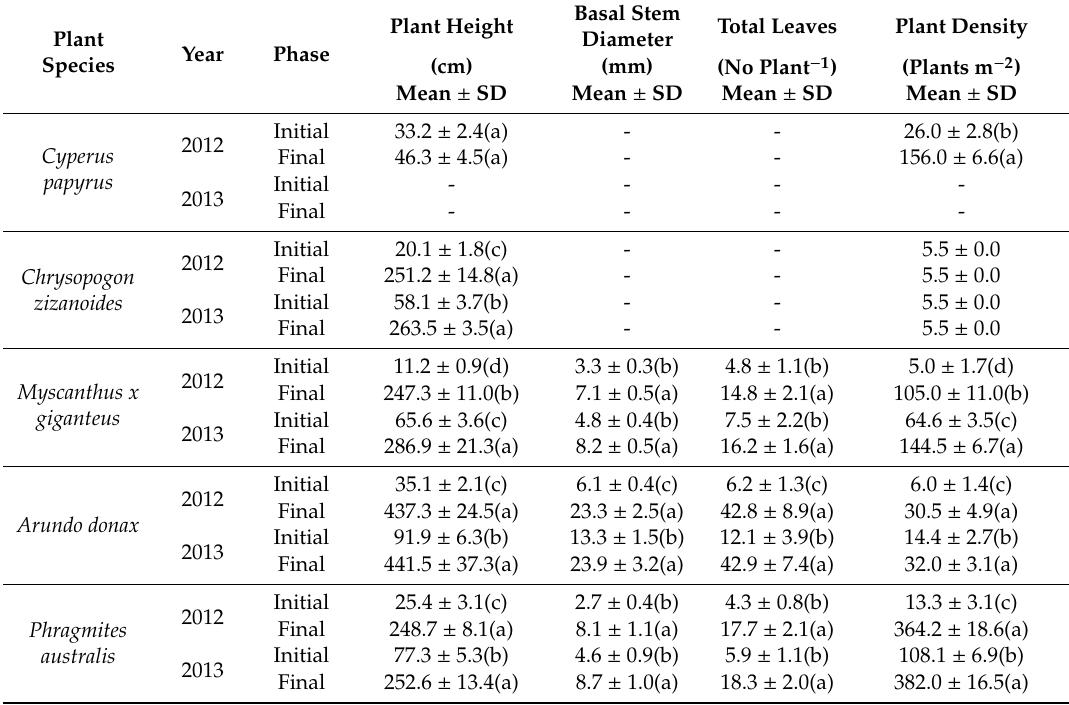
Table 3. Mean values and standard deviation ( ± SD) of plant height, basal stem diameter, total leaves, and plant density of herbaceous species at the beginning (initial) and end (final) of each investigation